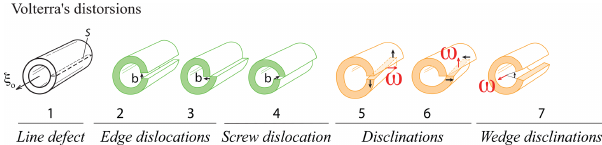
Figure 12. Volterra’s distortions (Volterra, 1907). Sketches present- ing the different types of deformation induced by (1) a line defect, (2–4) translation defects (dislocations) characterized by the Burg- ers vector b , and (5–7) rotation defects (disclinations) characterized by the rotation vector f (not shown; only the axis of rotation ω is shown as a black